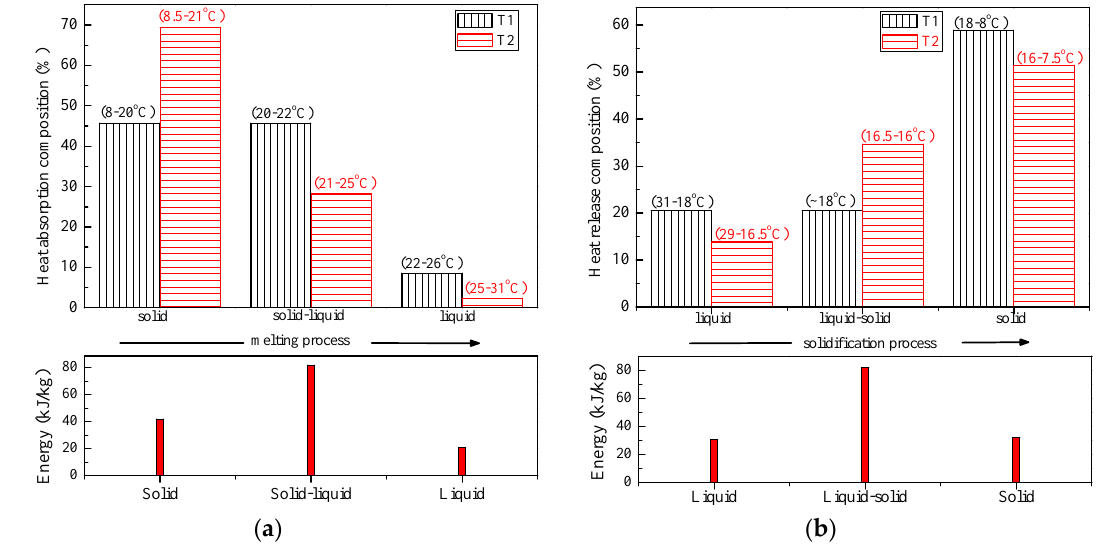
Figure 4. The estimated amount of heat exchanged from the co_oil during ( a ) heat absorption and ( b ) heat release processes. The temperature ranges for each phase region are also indicated for the two thermometers.